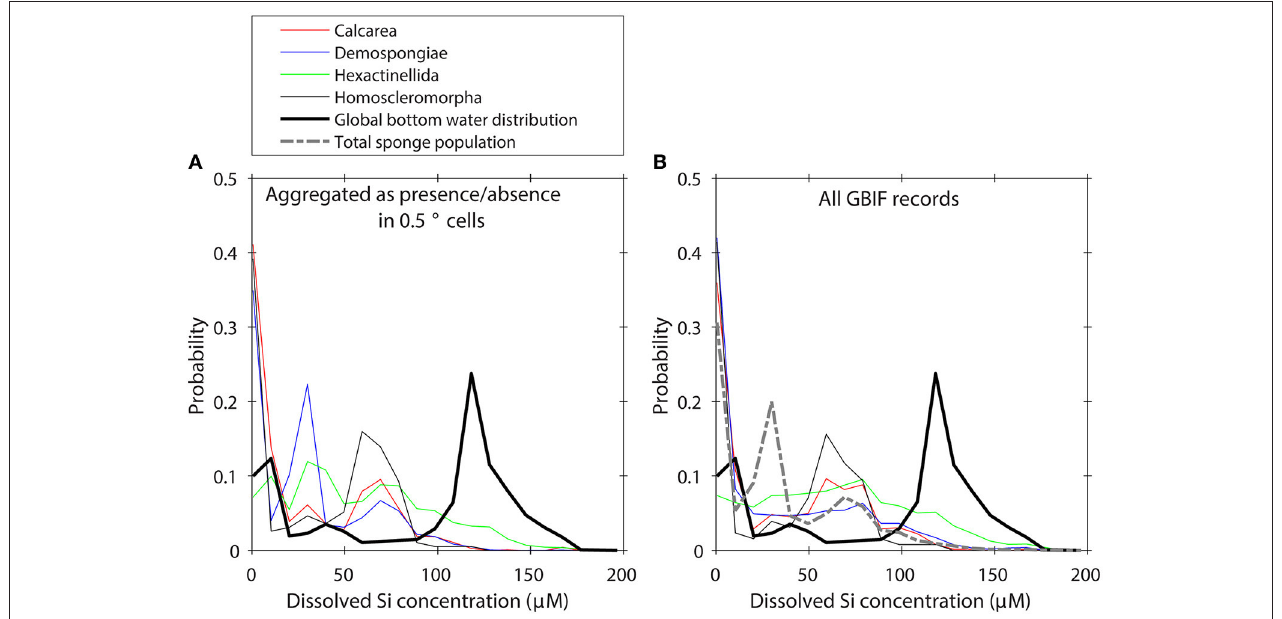
FIGURE 2 | (A) Global distribution of GBIF records aggregated as presence/absence values in 0.5 ◦ boxes of the WOCE dataset. (B) Global distribution of GBIF records without correction for sampling